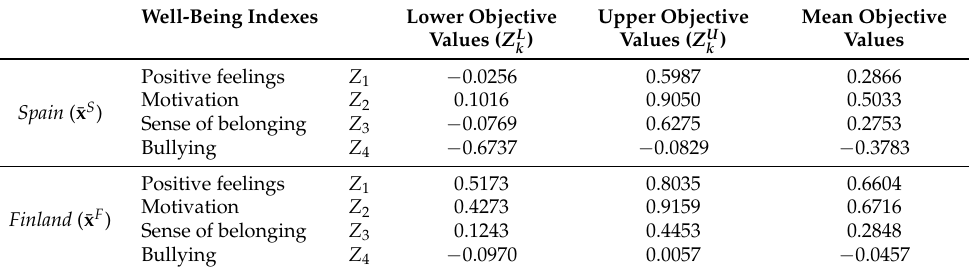
Table 9. Optimal interval objective values at the solutions to problems (3) and (4).